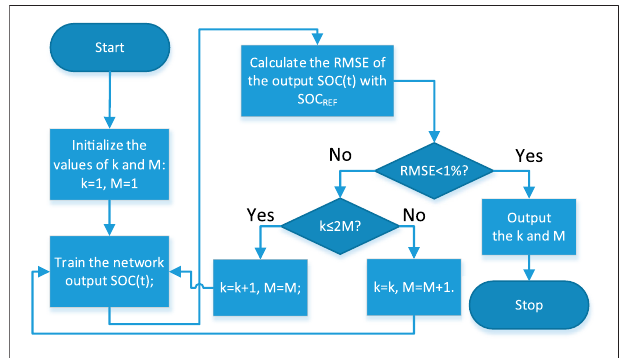
FIGURE 5 | The selection process of the main parameters of the NN